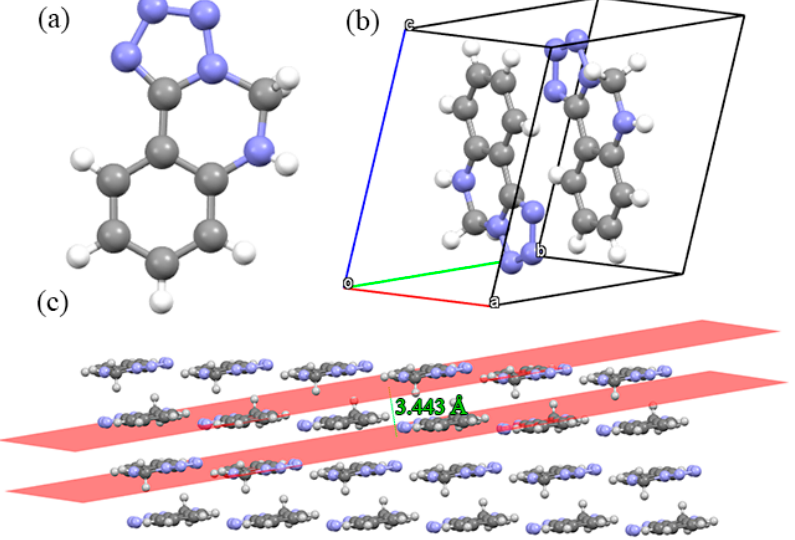
Figure 2. Crystal structures and geometrical configuration of Crystal a : ( a ) crystal structure; ( b ) single unit cell; ( c ) the 3D extended structure.